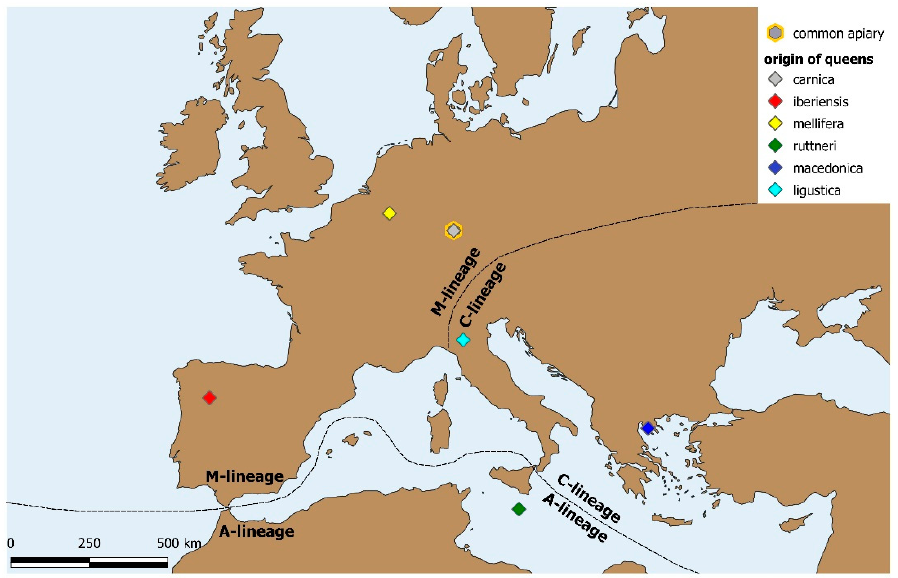
Figure 1. Map of lineage distribution ranges and points of origin of the different honeybee subspe- cies studied.